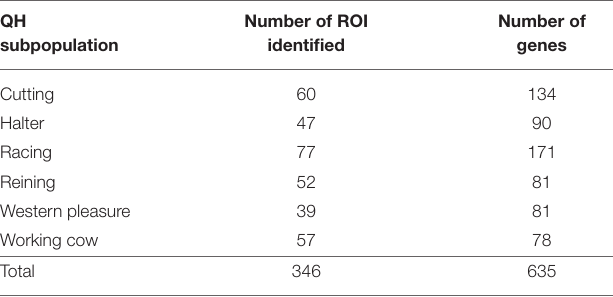
Number of ROI identified